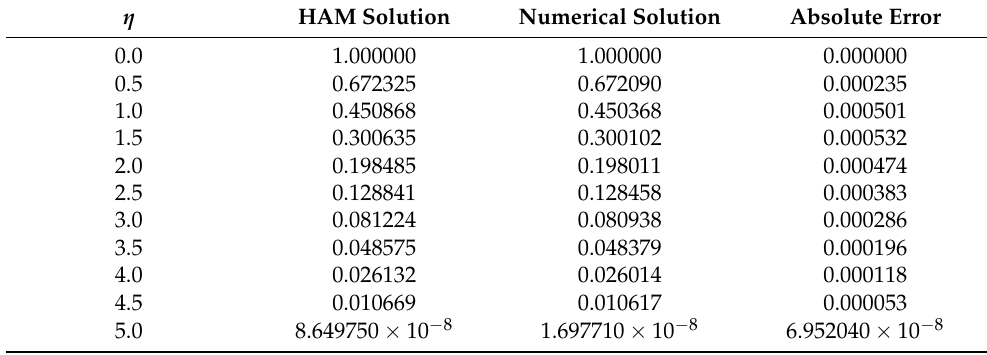
Table 2. Comparison table for HAM solution and numerical method for velocity field and their results.